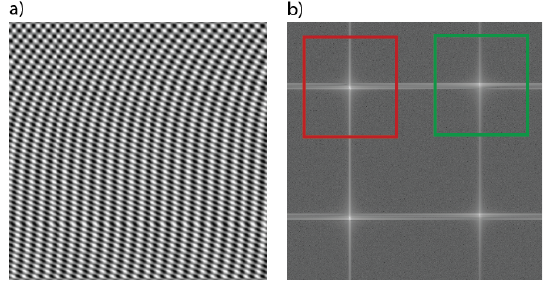
sepctrum. Red and green rectangles represent wavefronts of generated by the measured phenomena at different